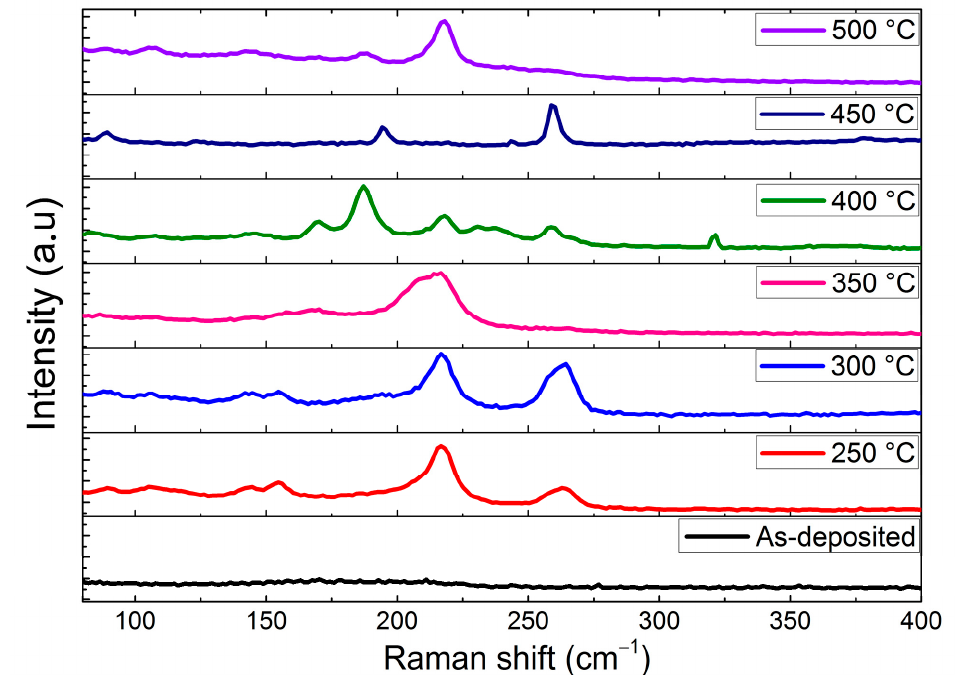
Figure 5. Raman spectra of the CuSbSe 2 thin films deposited at − 0.4 V/SCE during 30 min and annealed at different temperature for 10 min in N 2 atmosphere.